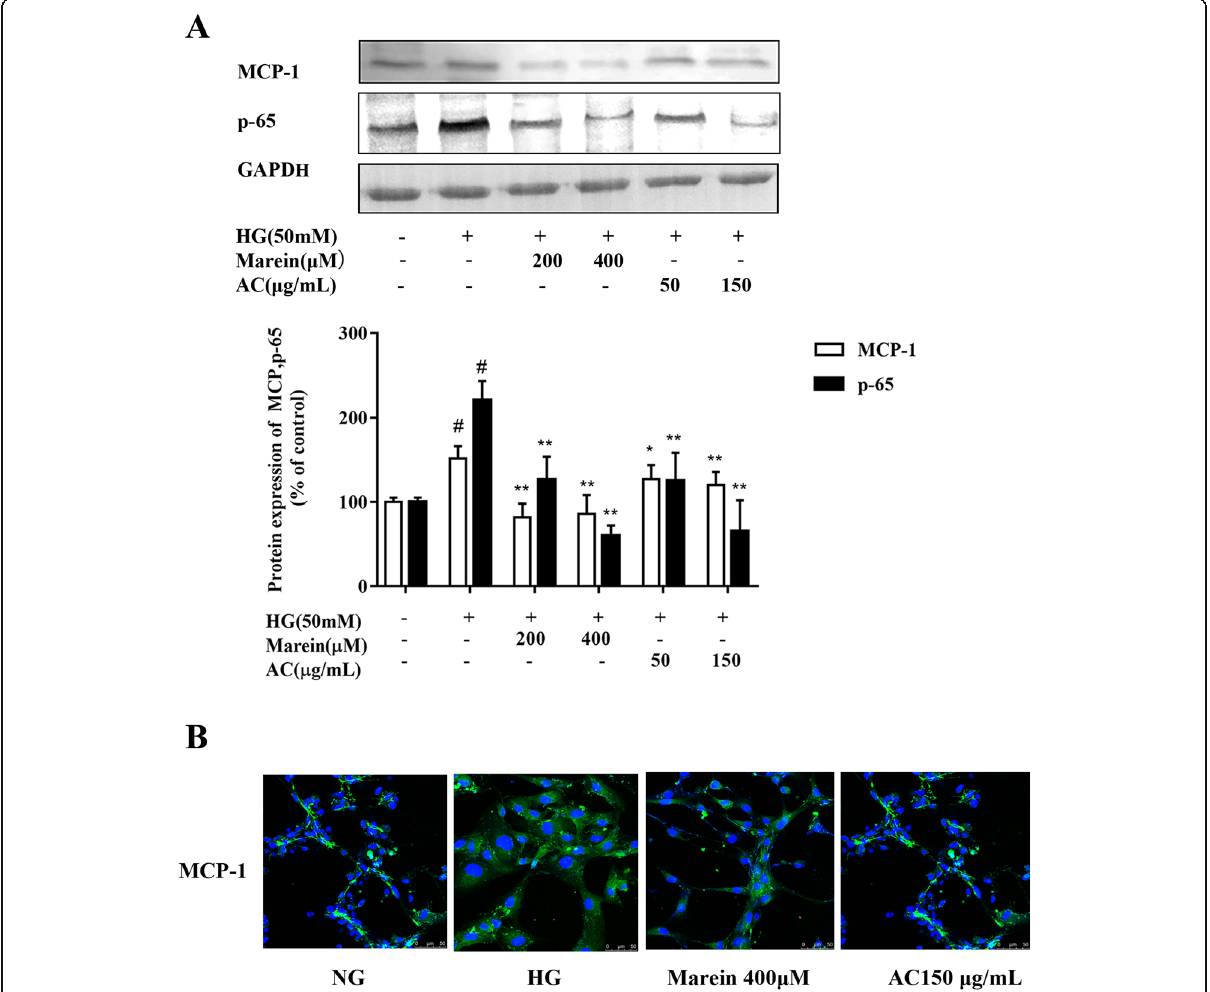
Fig. 6 a Effect of AC and marein on MCP-1 expression in HG-treated HBZY-1 cells by western blots. b Effect of AC and marein on MCP-1 distribution change by immunofluorescence. Note: Values were expressed as the mean±SD, n=4. # P< 0.01 versus normal group; * P< 0.05 versus control group; ** P< 0.01 versus control